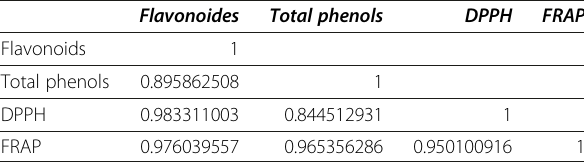
Table 2 Pearson ’ s correlation coefficients (r) between the analysis